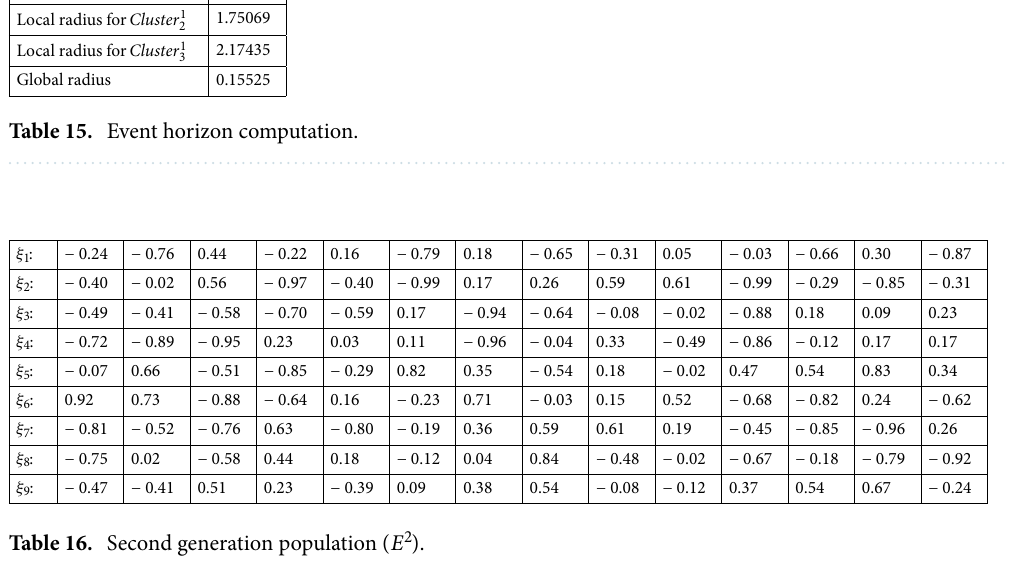
Table 16. Second generation population ( E